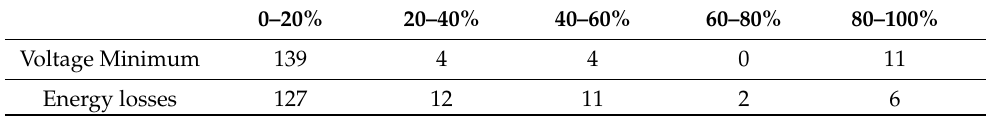
Table 9. AMD of the values obtained (10% variation in demand).